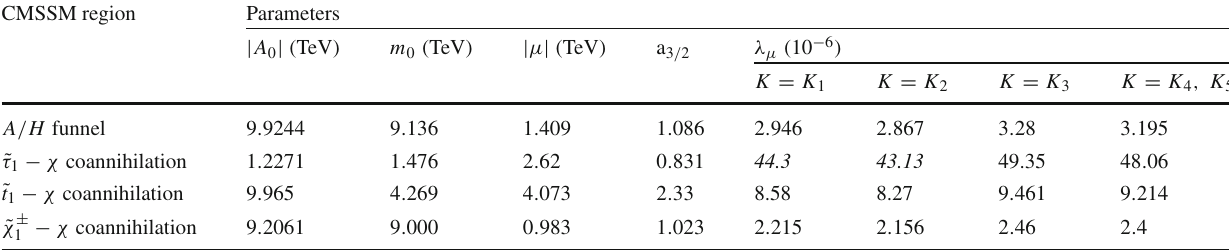
Table 4 The required λ μ values rendering our models for n = 0 compatible with the best-fit points of the CMSSM as found in Ref. [58] with the assumptions in Eq. (74) CMSSM